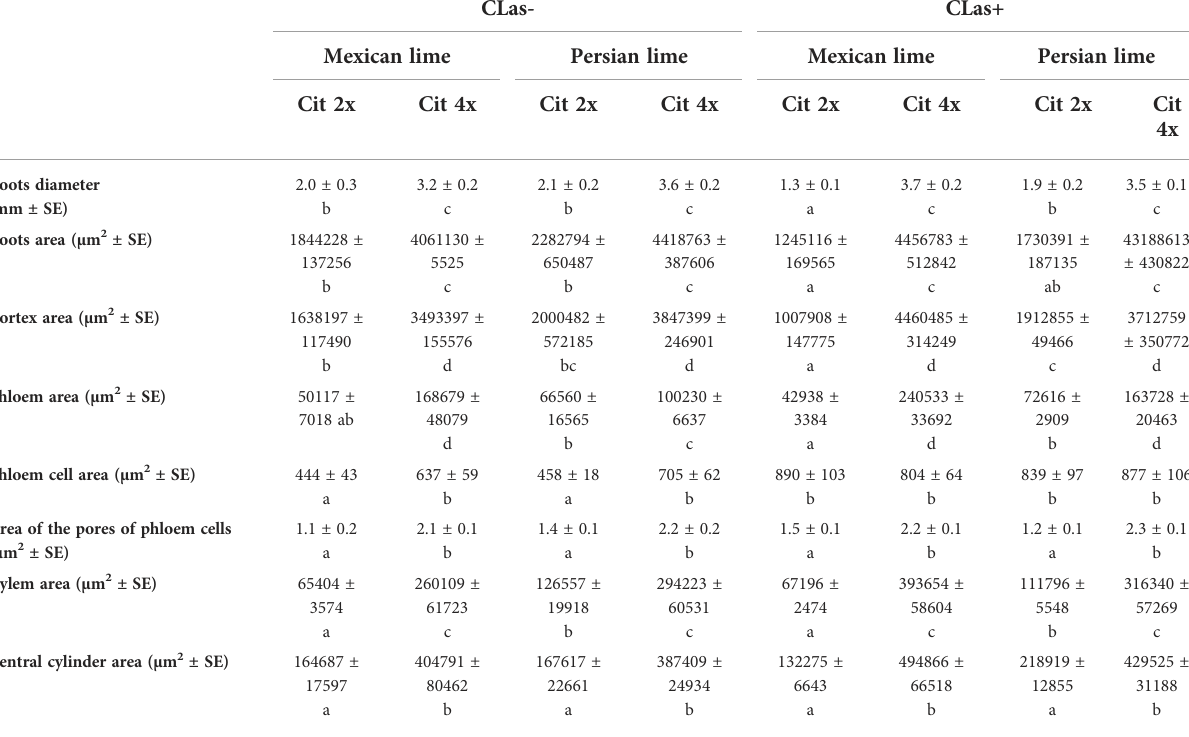
TABLE 3 Anatomical characterization of 2x or 4x Swingle citrumelo Swingle rootstock grafted with Mexican lime or Persian lime, infected (CLas+) or not (CLas-) by Candidatus Liberibacter asiaticus. CLas- CLas+ Mexican lime Persian lime Mexican lime Persian